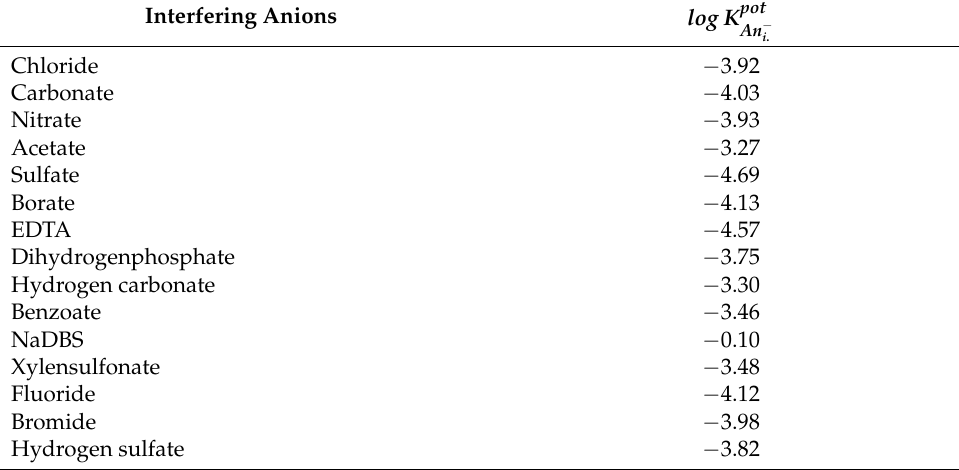
Table 2. Calculated logarithm of selectivity coefficient for different inorganic and organic anions (0.01 M) mostly used in product formulations, measured with the DHBI-TPB surfactant sensor for SDS. Interfering Anions log K pot